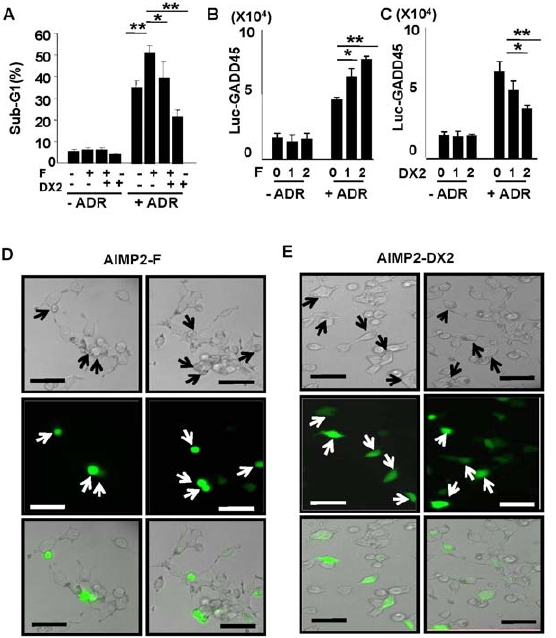
Figure 3. AIMP2-DX2 compromises pro-apoptotic activity of AIMP2-F. (A) AIMP2-F and –DX2 were transfected into A549 cells and their effects on adriamycin-induced cell death were compared by sub- G1 population using flow cytometry. *: P , 0.05 . **: P , 0.01 . A549 cells were transfected with luciferase reporter gene under the control of GADD45 promoter with the indicated amounts of AIMP2-F (B) or AIMP2-DX2 (C), and incubated for additional 12 hours. Adriamycin was treated to the transfectants for 12 hours and luciferase activity